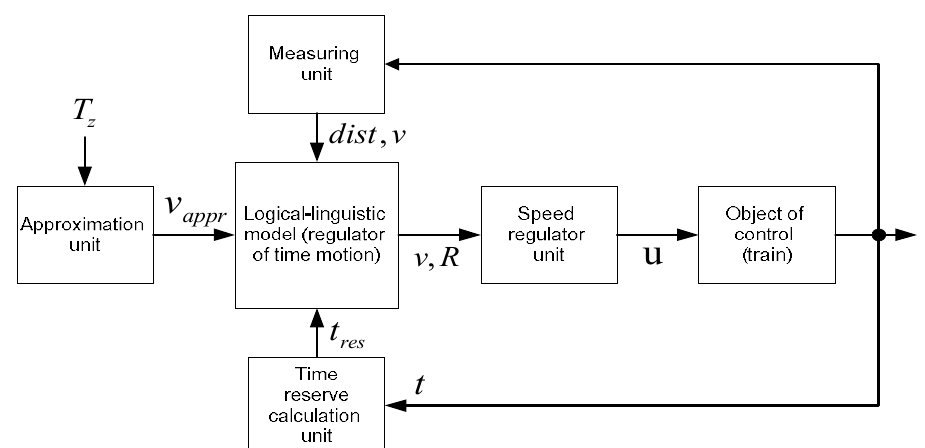
Figure 3. The suggested functional diagram of automatic train operation